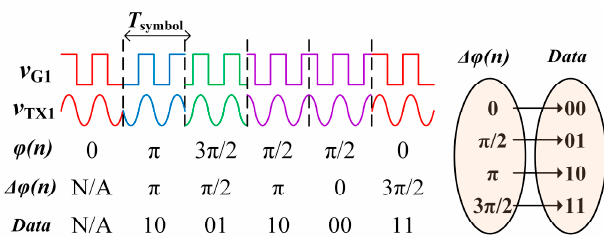
Figure 2. Differential quadrature phase-shift keying (DQPSK) modulation of data transmitter.